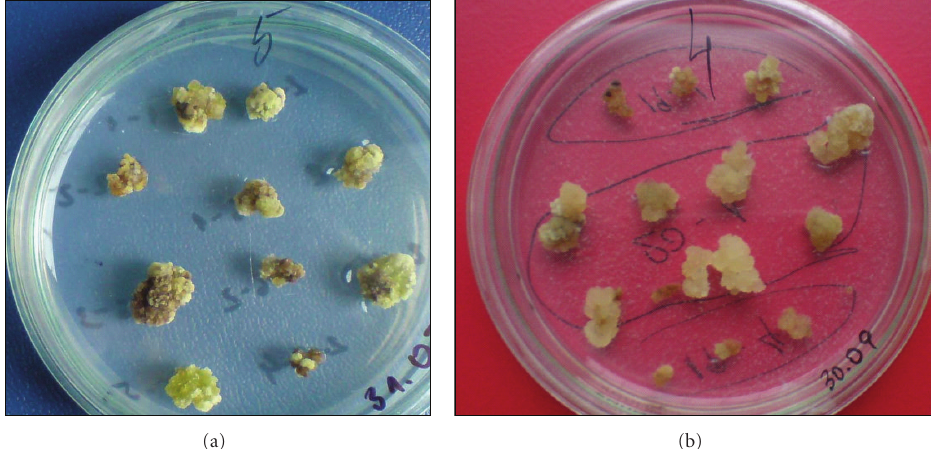
Figure 12: Callus growth after the 3rd passage on di ff erent media: variant (a) MS medium enriched with 0.5mg/L BAP and 1mg/L 2,4-D; variant (b) MS medium enriched with 1mg/L BAP and 0.5 mg/L